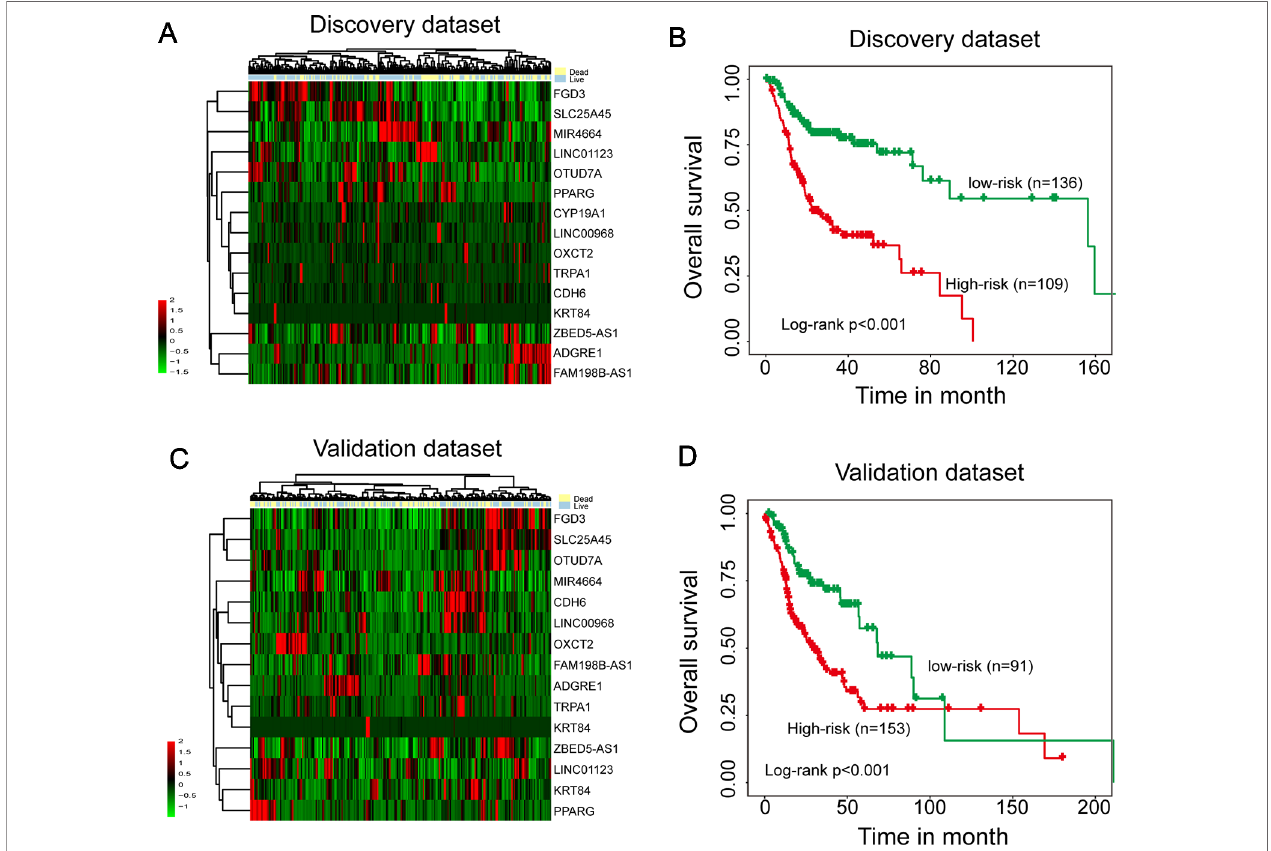
FIGURE 1 | Identi fi cation of independent survival-related mRNAs, miRNAs, and lncRNAs. (A) Hierarchical clustering analysis of 245 patients in the discovery data set using 15 prognostic genes. (B) Kaplan – Meier survival curves of overall survival between two clusters in the discovery data set. (C) Hierarchical clustering analysis of 244 patients in the validation data set using 15 prognostic genes. (D) Kaplan – Meier survival curves of overall survival between two clusters in the validation data